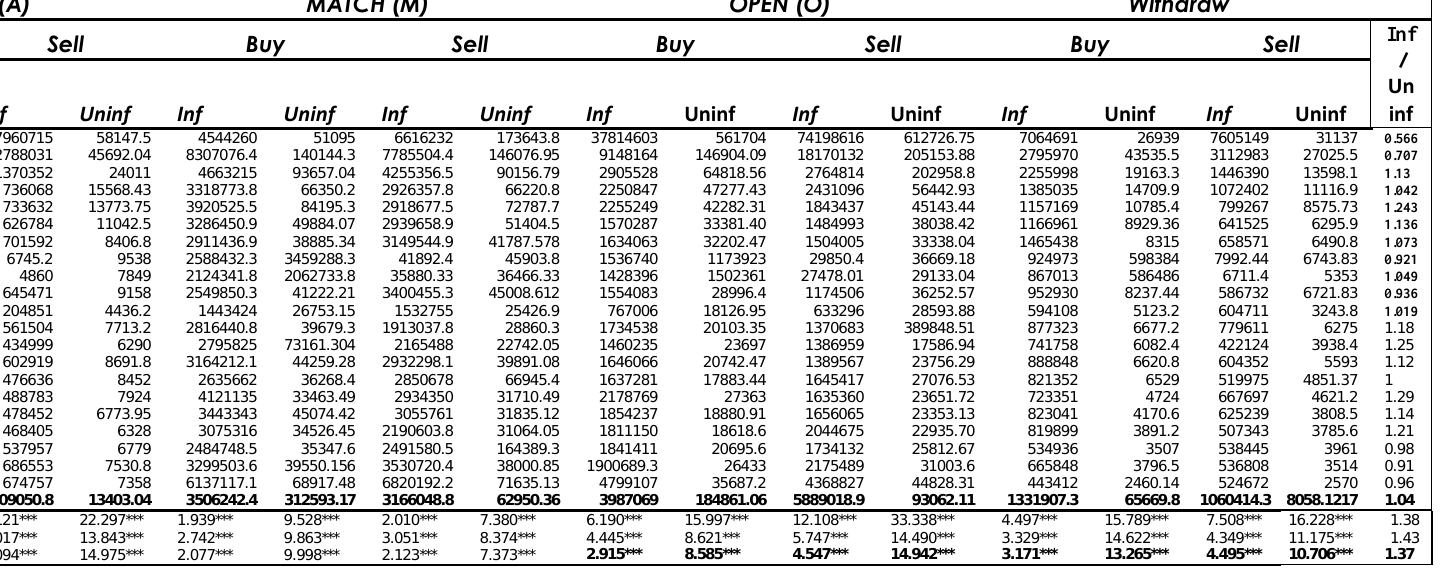
Sumber: Data Diolah dengan SPSS versi